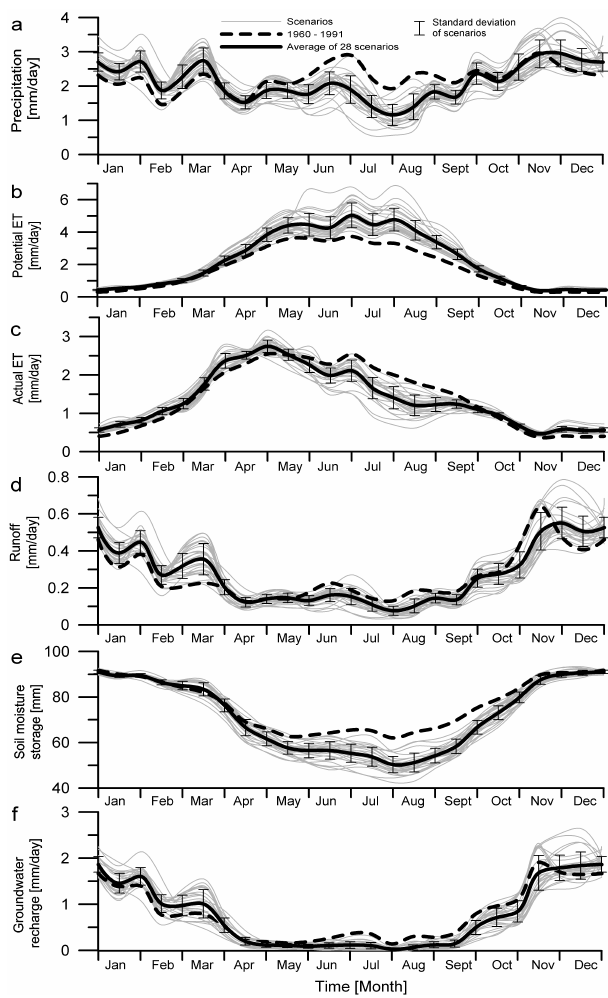
Fig. 7. Average intra-annual variability of (a) precipitation, (b) po- tential ET, (c) actual ET, (d) runoff, (e) soil moisture storage and (f) groundwater recharge for the reference climate (1960–1991), 28 climate scenarios (2070–2101) and the average of the climate sce- narios. One year is divided into 24 half monthly time steps, for ev- ery time step the average of 32yr simulation is presented. Error bars represent one standard deviation between the climate